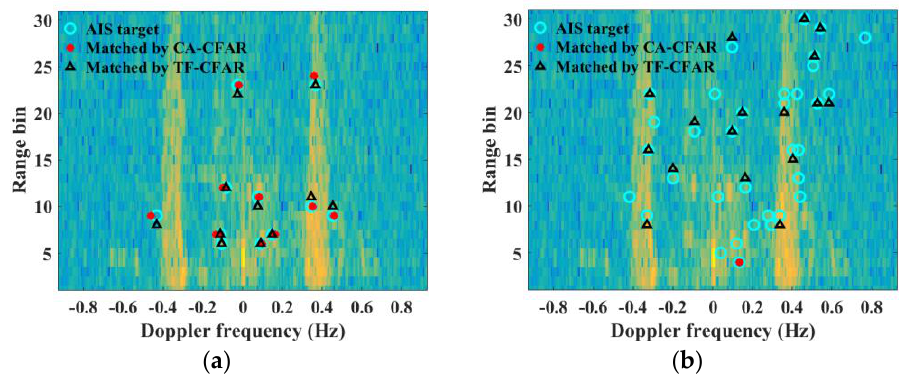
Figure 7. Target-matching maps by TF-CFAR and CFAR at 06:51 on 25 September 2015 in the case of ( a ) same results and ( b ) different results.